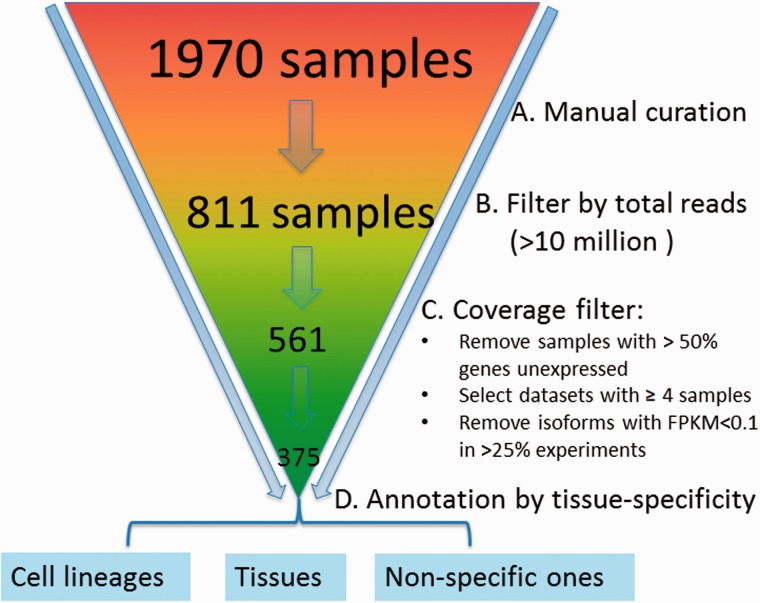
Preprocessing and quality control of RNA-seq data. The initial set of 1970 samples downloaded from the SRA database was first manually examined to ensure that samples have are only from RNA-sequencing of mouse samples followed by removal of those with <10 million reads, resulting in 561 samples. Data are further processed by (i) removing samples with >50% genes unexpressed, (ii) removing datasets with <4 samples, (iii) removing isoforms with RPKM < 0.1 in >25% experiments and (iv) log2 transformation; 375 samples were retained finally and grouped into 43 datasets, which are mainly cell lineage- or tissue-specific.